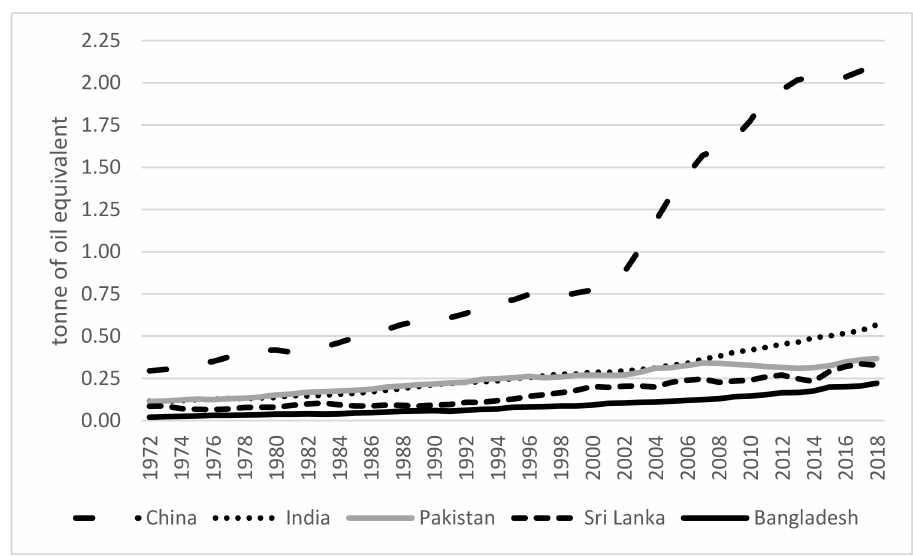
Figure 1. Per capita energy use (tonne of oil equivalent per